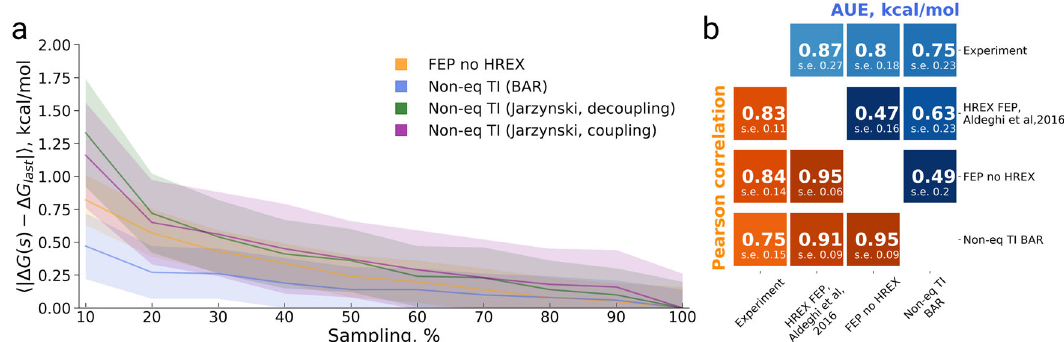
Fig. 4 Bias analysis of absolute binding free energies for a set of 11 ligands binding to BRD4(1). a Bias with respect to the fi nal estimate using the whole available sampling against the invested sampling time. b Matrix comparing the calculation approaches, as well experimental measurement, in terms of Pearson correlation and average unsigned error (AUE). The uncertainties denote standard errors obtained by